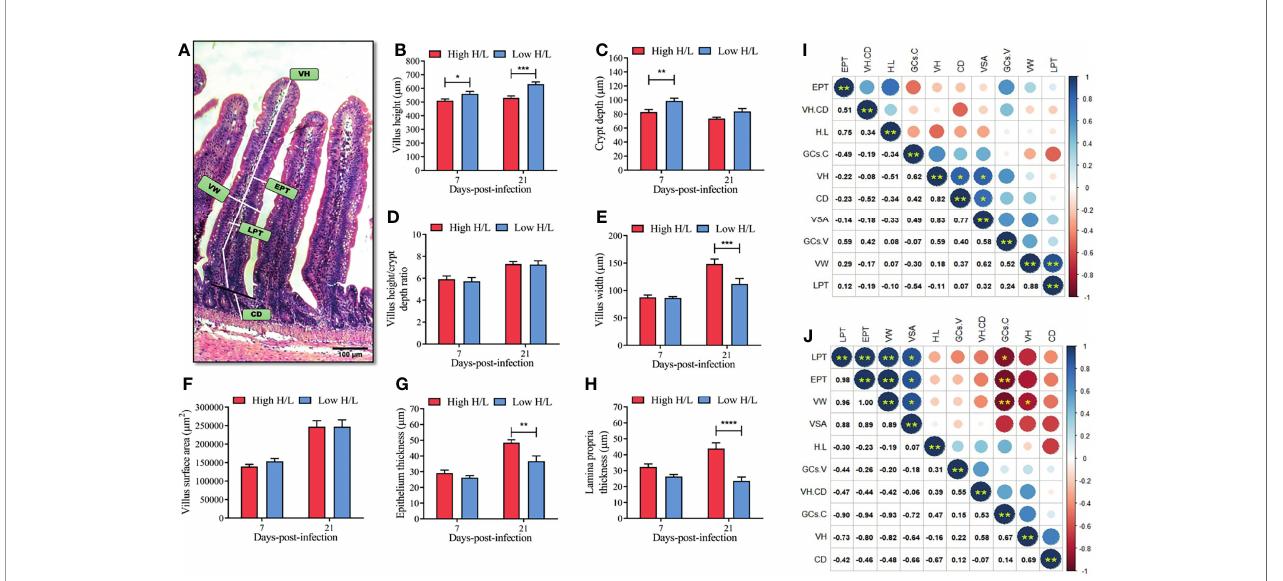
FIGURE 3 | Ileal villi morphometry differences between high and low H/L ratio chickens at 7 and 21 days after S. Enteritidis infection. At 7 and 21 dpi, sections of 5µm of thickness from the ileum stained using hematoxylin and eosin (HE) were used for intestinal villi morphometry (n = 2; 10 villi and 20 crypts each bird); (A) ileal villi morphometry indexes; (B) villus height (VH) difference between low and high H/L ratio chickens SE-infected at 7 and 21 dpi; (C) Crypt depth (CD) difference between low and high H/L ratio chickens SE-infected at 7 and 21 dpi; (D) Villus height/crypt depth ratio (VH/CD) difference between low and high H/L ratio chickens SE-infected at 7 and 21 dpi; (E) villus width (VW) difference between low and high H/L ratio chickens SE-infected at 7 and 21 dpi; (F) villus surface era = p × villus height × villus width (VSA) difference between low and high H/L ratio chickens SE-infected at 7 and 21 dpi; (G) Epithelium thickness (EPT) difference between low and high H/L ratio chickens SE-infected at 7 and 21 dpi; (H) Lamina propria thickness (LPT) difference between low and high H/L ratio chickens SE-infected at 7 and 21 dpi; (I, J) spearman correlation between the different parameters related to the intestinal immune barrier function at 7 and 21 dpi, respectively; *p < 0.05, **p < 0.01, ***p < 0.001, ****p < 0.0001. Data analysis was performed using 2-way ANOVA with Sidak ’ s multiple comparisons, with alpha =